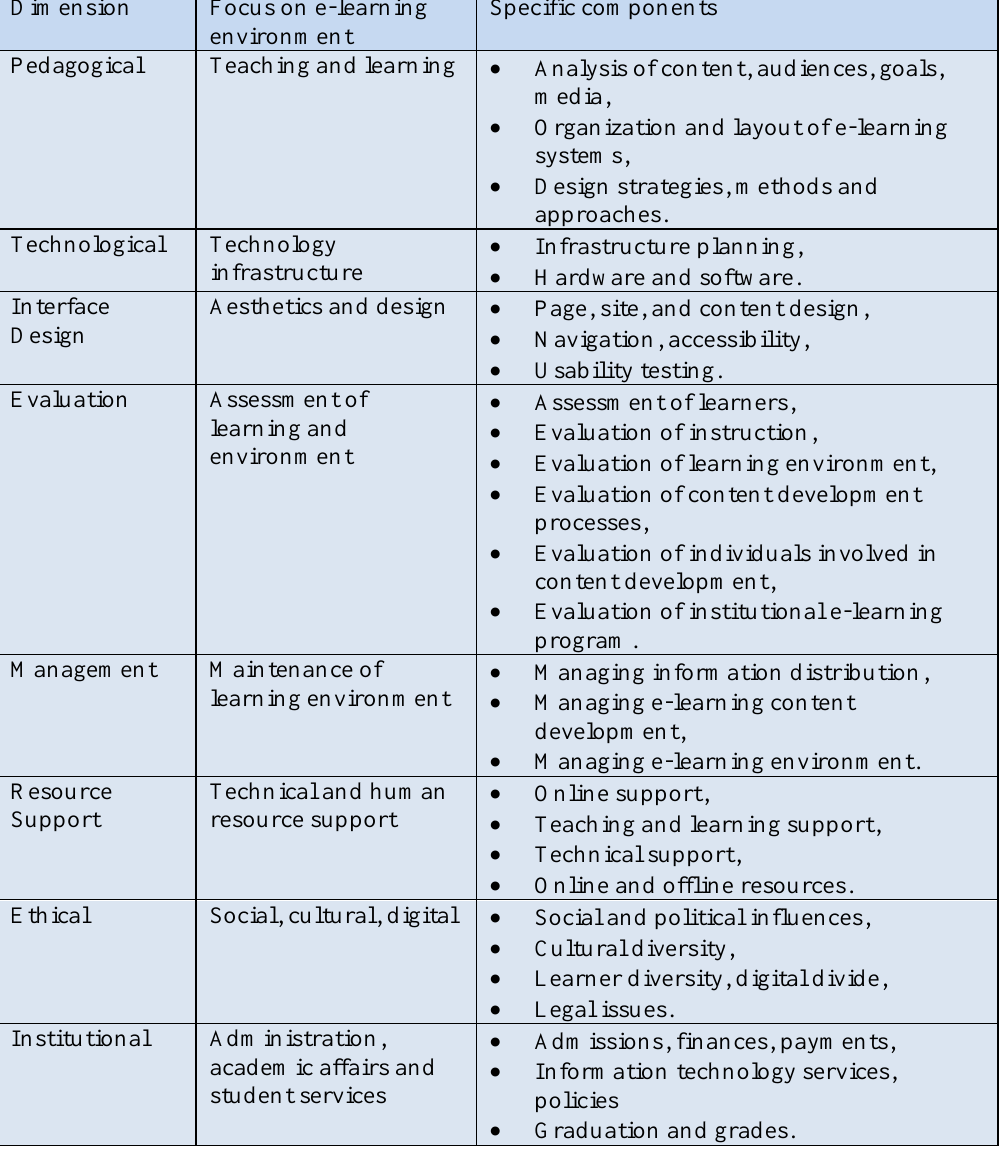
Table 1 E-Learning Framework Summarized by Aguti, Walters & Wills (2013)